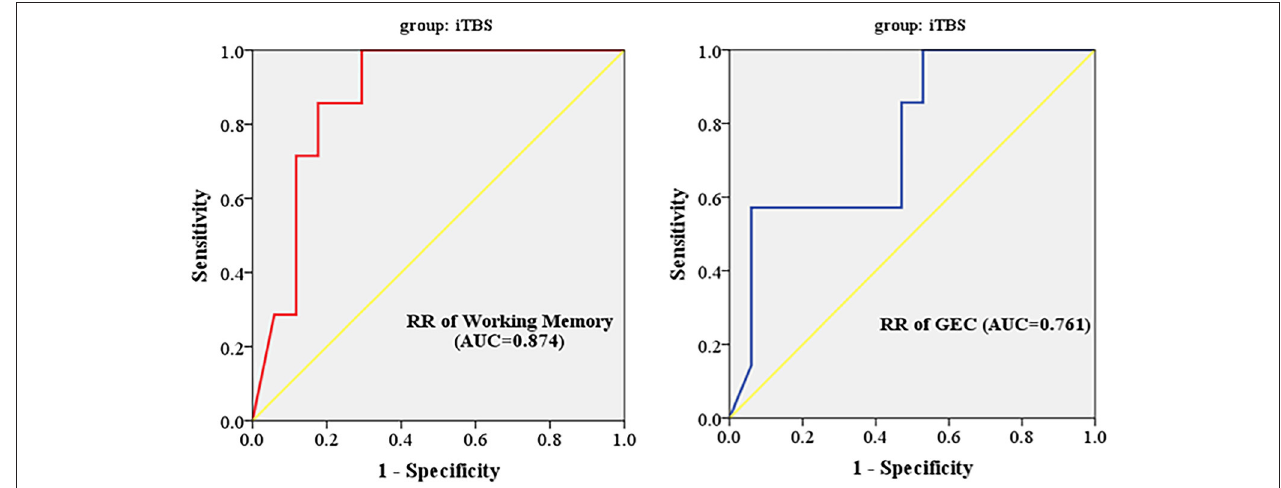
FIGURE 3 | Working memory subscale scores and GEC had predictive power to iTBS therapeutic efficacy. RR, reduction rate; GEC, global executive composite; AUC, area under the curve; iTBS, intermittent theta burst